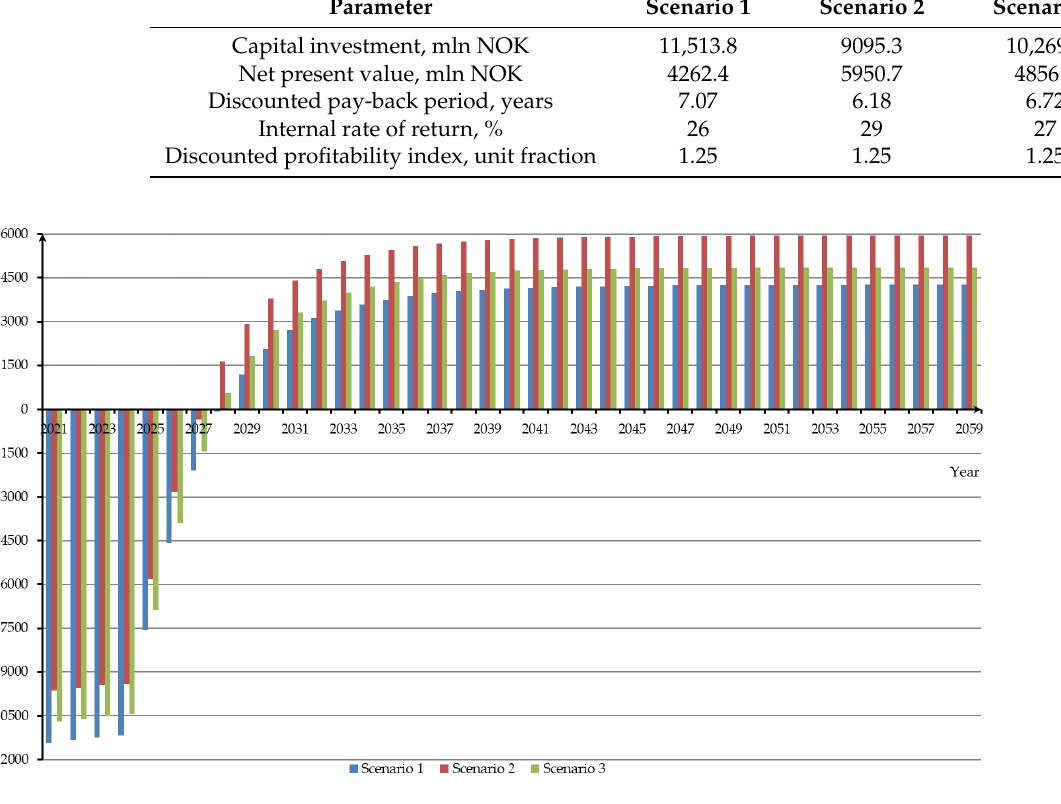
Figure 9. The change in accrued net present value during the